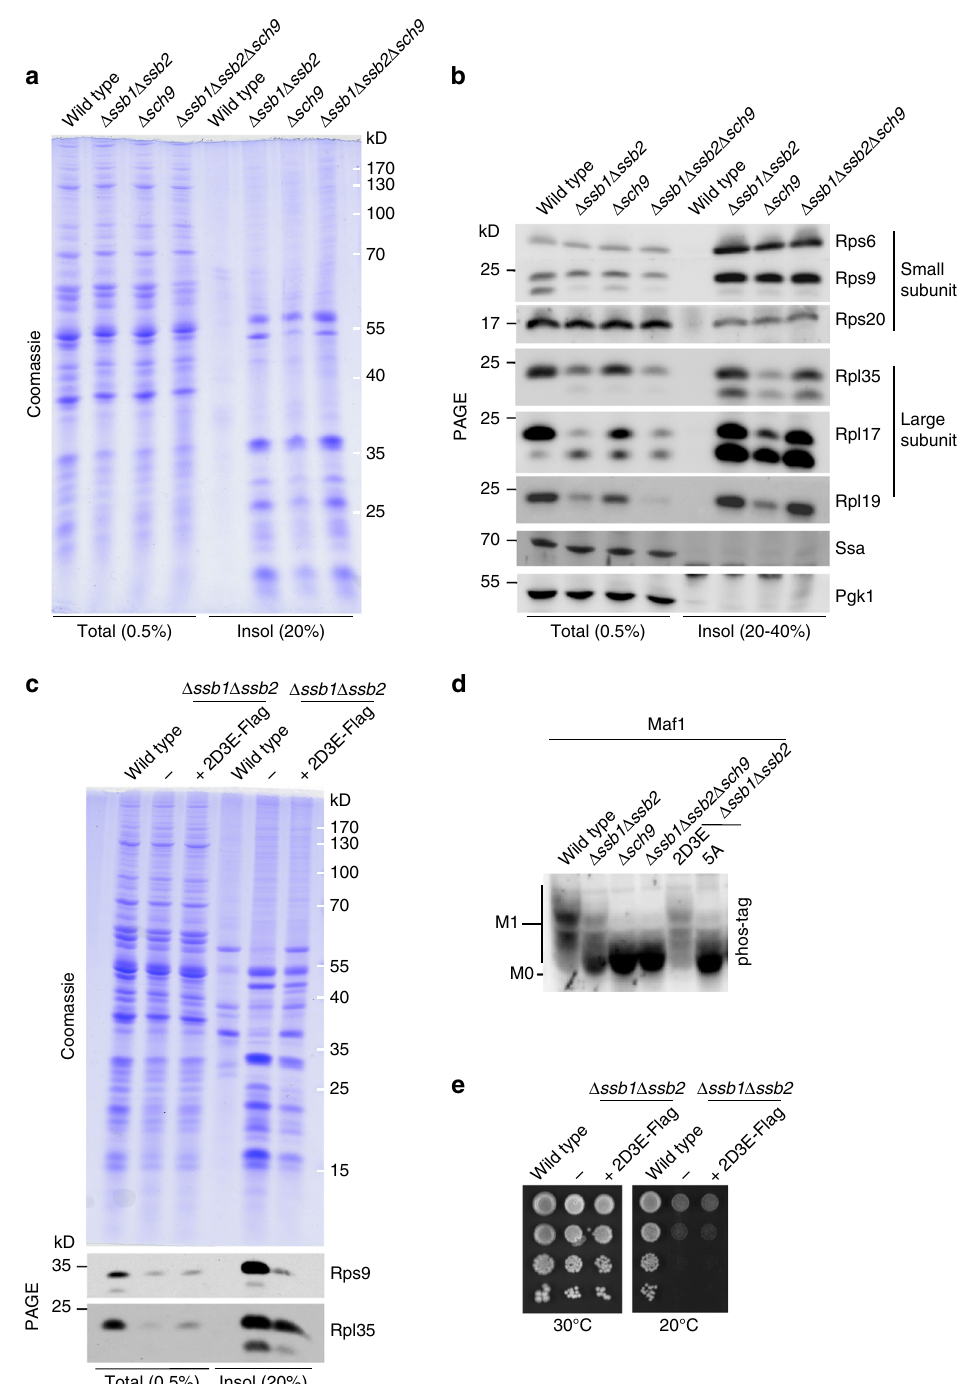
Fig. 4 Ribosome aggregation in cells lacking Ssb is due to reduced Sch9 activity. a , b Aggregation of ribosomal proteins in cells lacking Ssb and/or Sch9. Insoluble material was prepared as described in Methods section. The indicated fractions of total cell extract (total) and insoluble material (insol) were separated on Tris-Tricine gels and were subsequently analyzed via Coomassie staining ( a ) or immunoblotting ( b ) employing the antibodies indicated. c Hyperactive Sch9-2D3E partially rescues ribosome aggregation in cells lacking Ssb. The experiment was performed and analyzed as described in a , b . d Hyper-active Sch9-2D3E partially rescues Maf1 phosphorylation in cells lacking Ssb. Protein extracts from the indicated strains were analyzed as described in Fig. 3c. e Hyper-active Sch9-2D3E does not complement for the general growth defects of cells lacking Ssb. Logarithmically growing cells from the strains indicated were serially diluted, spotted on YPD plates, and were incubated at the indicated